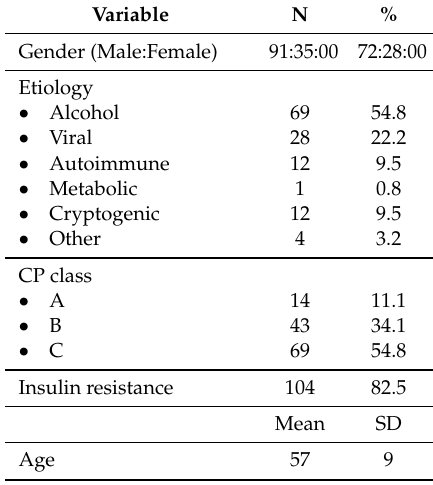
Table 1. Number and percent of participants and incidence of manifestations (CP class = Child–Pugh class, SD = standard